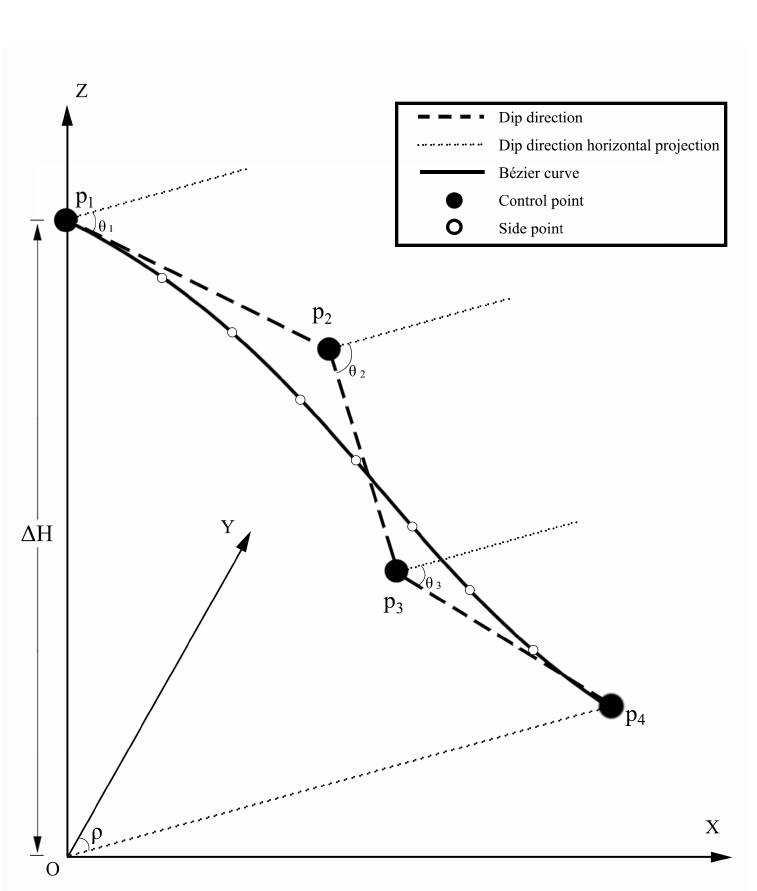
Figure 8. Side line constrained by Bézier, where p 1 , p 2 , p 3 and p 4 represent the four control points, the angle θ 1 to θ 3 represent the dip angle of these control points, respectively, and ρ is their dip direction, ∆ H represents the distance from p 1 to the bottom